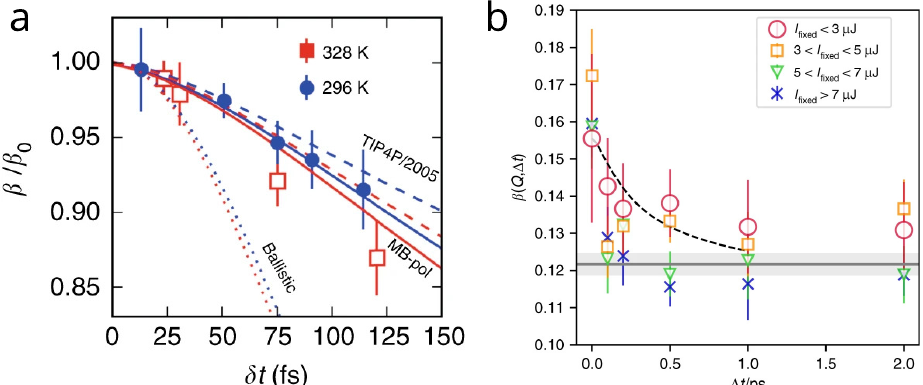
Figure 11. Dynamics of liquid water measured at FEL facilities. ( a ) By changing the pulse width, the speckle contrast obtained by XSVS follows expectations from molecular dynamics simulations [30]. ( b ) Longer times are achieved using a split-and-delay device at SACLA, where the speckle contrast depends on the pulse intensity suggesting radiation-induced dynamics [31]. Figures are reprinted from [30,31] under CC-BY